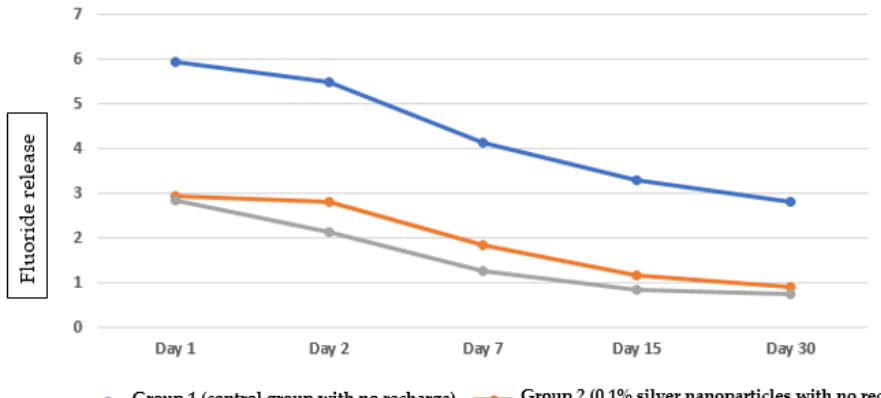
Figure 2. Pattern of fluoride release from the three groups at different time intervals without fluo- ride recharge.